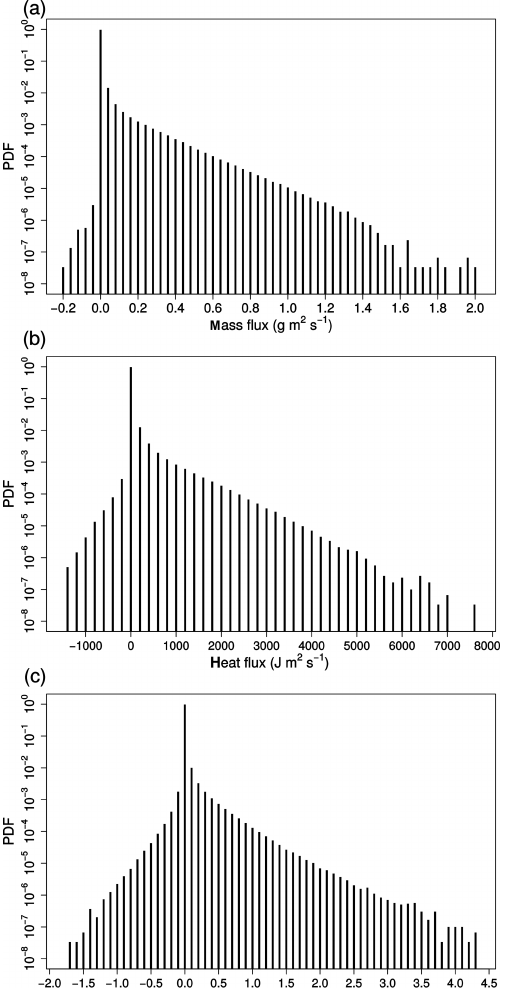
Figure 6. Probability density function (PDF) of the transport flux errors for water vapour (a) , enthalpy (b) and zonal wind (c) at model level 20 ( ∼ 250hPa).